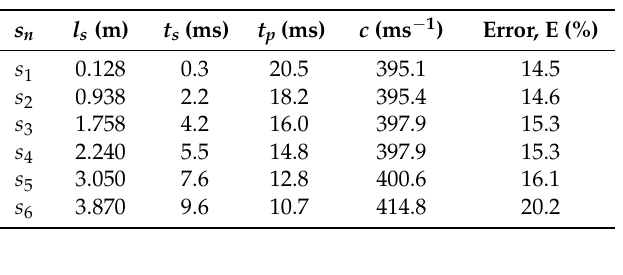
Table 1. Arrival Time of Compression and Rarefaction Wave-front using the acoustic continuum 3D 20-node brick elements (AC3D20).